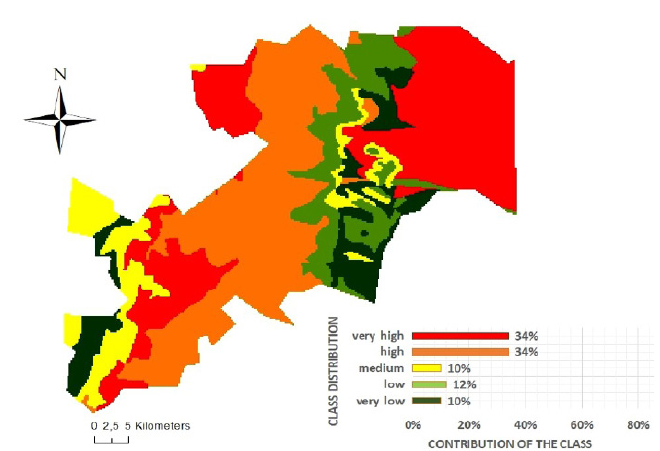
Figure 3. Komati Gorge geology factor